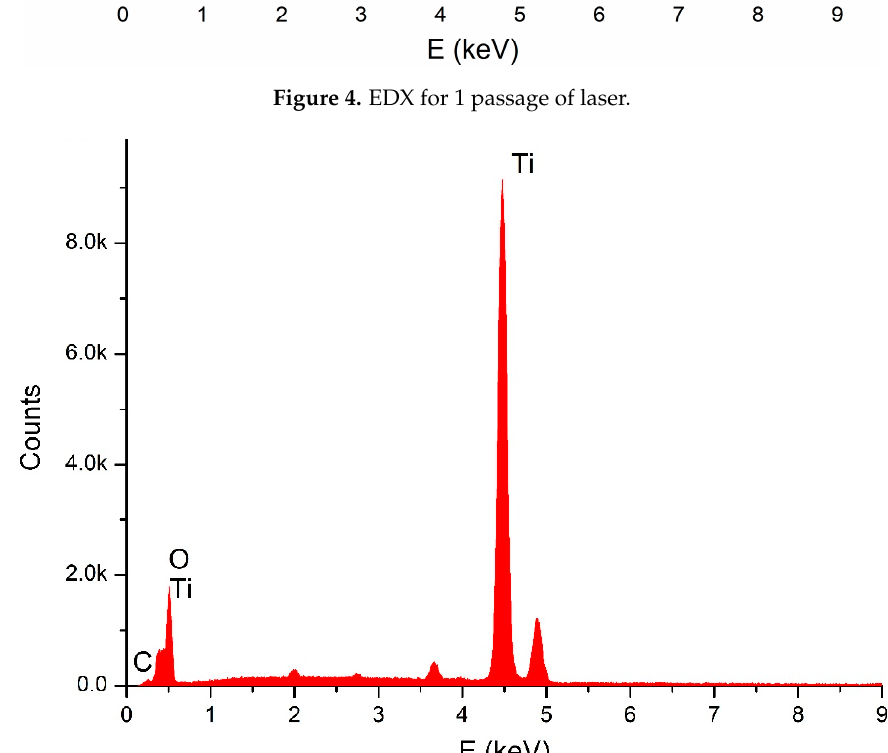
Figure 5. Energy-dispersive X-ray spectroscopy (EDX) for the three passages of laser.